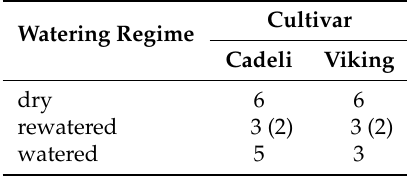
Table 1. Oilseed rape pot counts used in the experiment according to the experimental treatments. The parenthesised values refer to the counts after excluding a low-quality